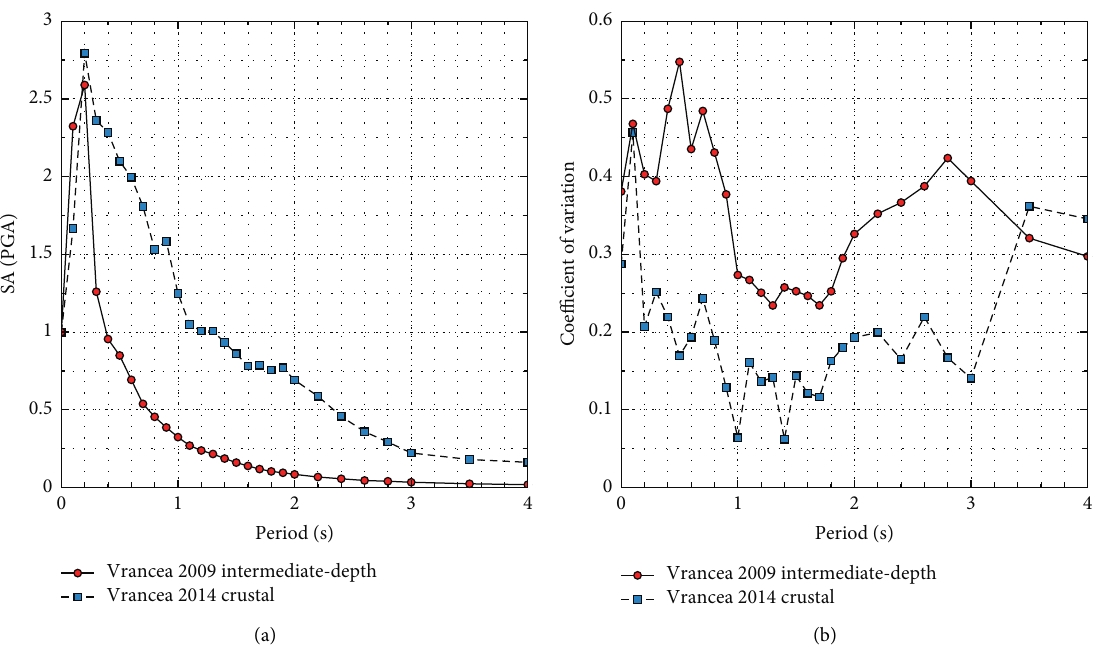
Figure 10: Mean normalised acceleration response spectra and coefficients of variation for the spectral accelerations for the Vrancea intermediate-depth earthquake of April 2009 and for the Vrancea crustal earthquake of November 2014.